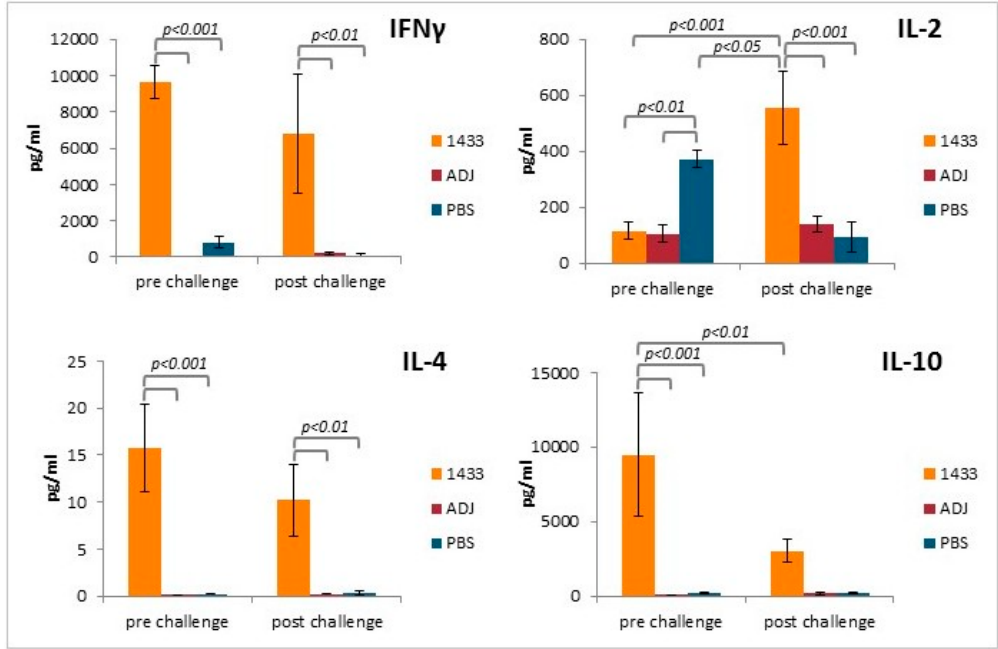
Figure 5. Cytokine profiles of mouse splenocytes after immunization and challenge. Supernatants harvested after 72 h of incubation were analyzed for detection of secreted cytokines IFN γ , IL-2, IL-4, and IL-10, using a Mouse Th1/Th2 uncoated ELISA kit. Experimental groups are indicated as previously described. Significantly different groups are marked with brackets and p value is indicated. Bars represent means ±SD from three splenocyte cultures, each prepared from two pooled spleens from mice from the immunized group ( n = 3), or means ±SD from three repeats of splenocyte cultures, prepared from three pooled spleens from mice from the control group ( n = 3).